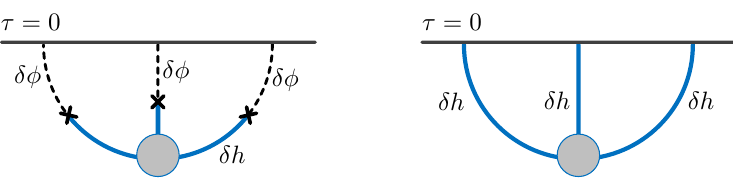
Figure 2 . The original \cosmological collider" vs. the \cosmological Higgs collider". Previous studies have considered the scenario of Higgs-modulated reheating